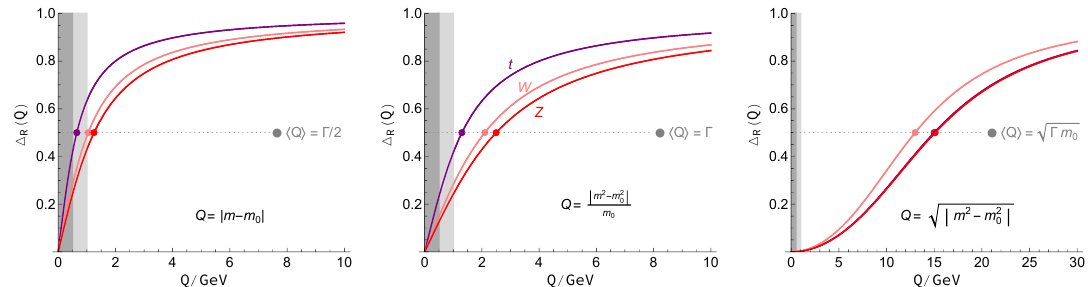
Figure 1: Resonance survival fractions ∆ , as functions of evolution scale Q , for R | = | m − m | (left), Q = | m 2 − m 2 | / m = (cid:113) | m 2 − m 2 Q (middle), and Q RES 0 RES 0 RES 0 0 (right). Each plot shows the surviving fraction of top quarks, W bosons, and Z bosons, in purple, pink, and red, respectively. A typical range of QCD shower cutoff values, from 0.5 to 1 GeV, is shown with light gray shading, while the region below 0.5 GeV is shaded darker gray. (As of Pythia 8.306, the default value in Vincia is 0.75 GeV, in the middle of the light-gray region.) The median values of Q , correspond- RES = 0.5, are highlighted by dots on each ing to ∆ R